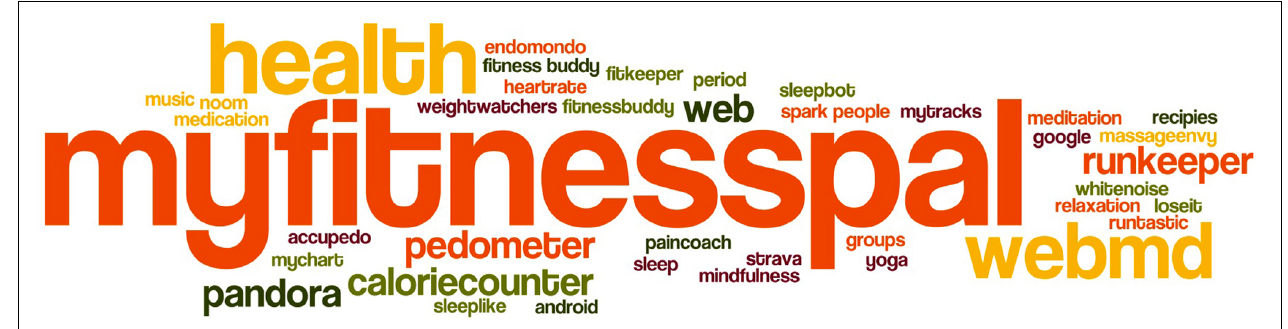
FIGURE 1 | Mobile health applications used by study participants.